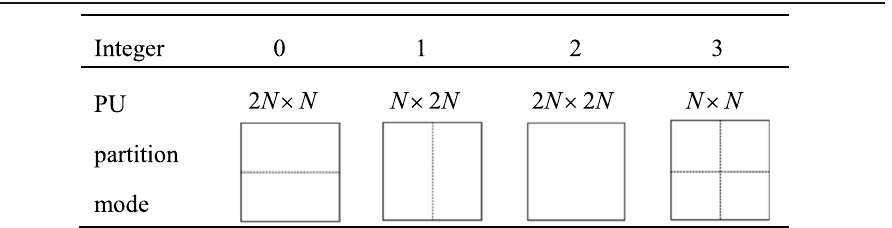
Table 8 Mapping 1 of PU partition modes for 8 ×8-sized